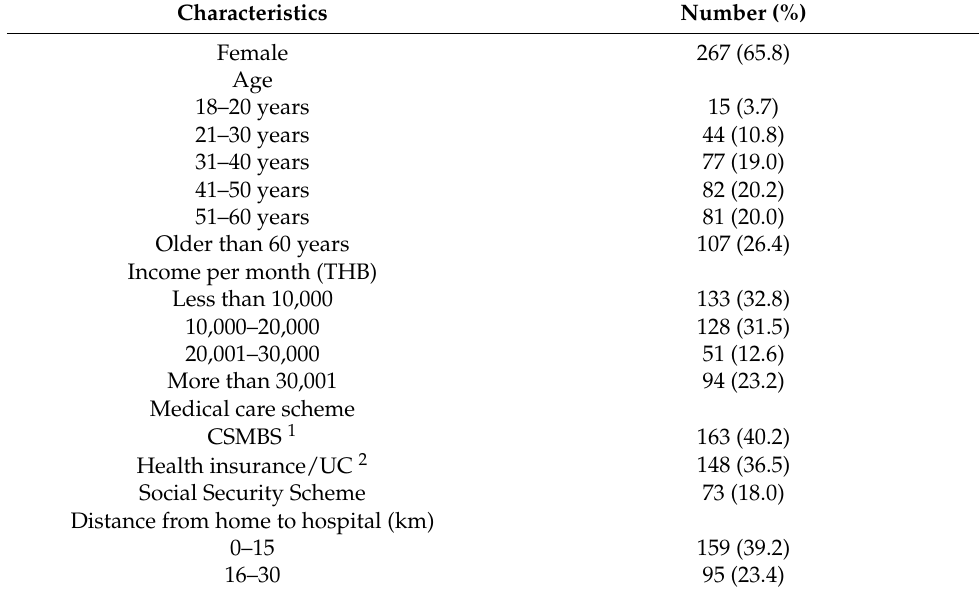
Table 1. Baseline characteristics of NCD patients that were recruited for the analysis ( n =